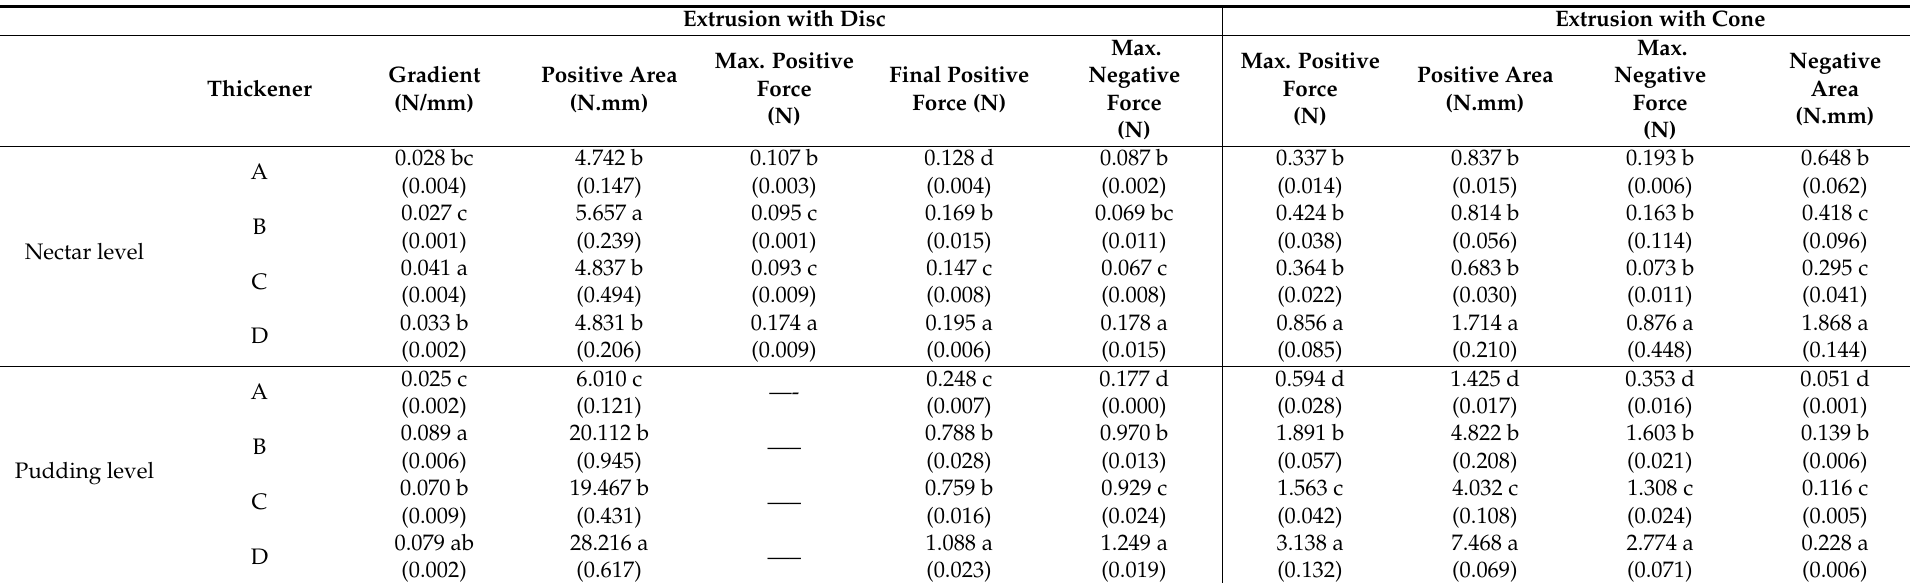
Table 4. Back-extrusion values with disc or cone at a speed of 1 mm s − 1 at nectar and pudding